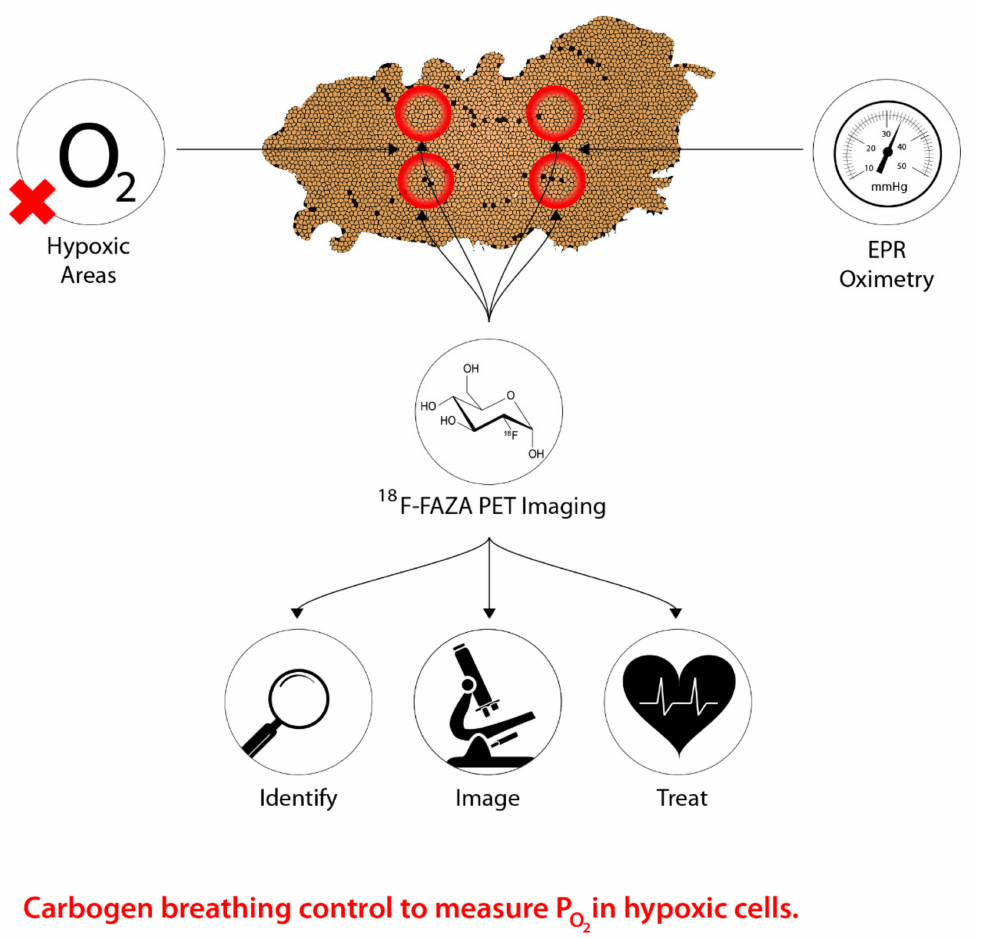
Figure 2. The concept underlying PET imaging to optimize carbogen breathing approaches to defeating hypoxia in radiotherapy. Oxygen levels are measured as the tumour is imaged, thus allowing precise identification of hypoxic regions, which can then be effectively